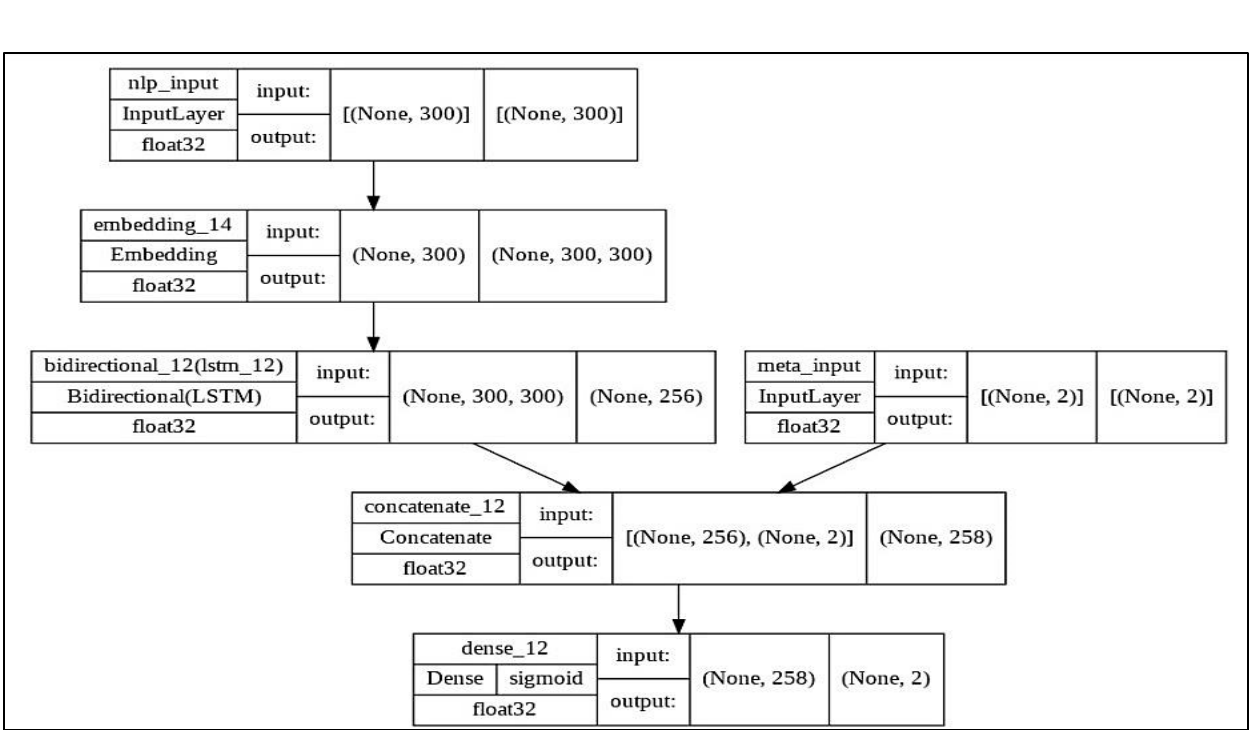
Figure 12. The concatenation layer in the proposed